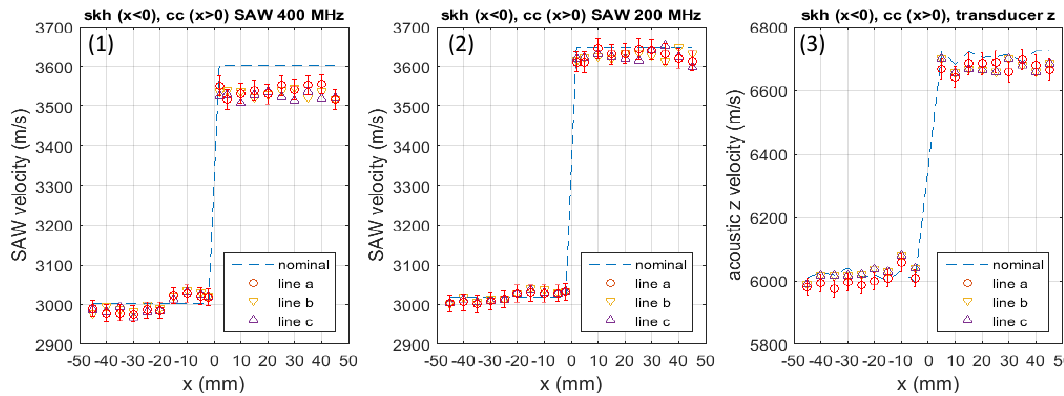
Figure 5. Acoustic velocity in z direction measured with (1) SAM 400 MHz, (2) SAM 200 MHz and (3) contact acoustic